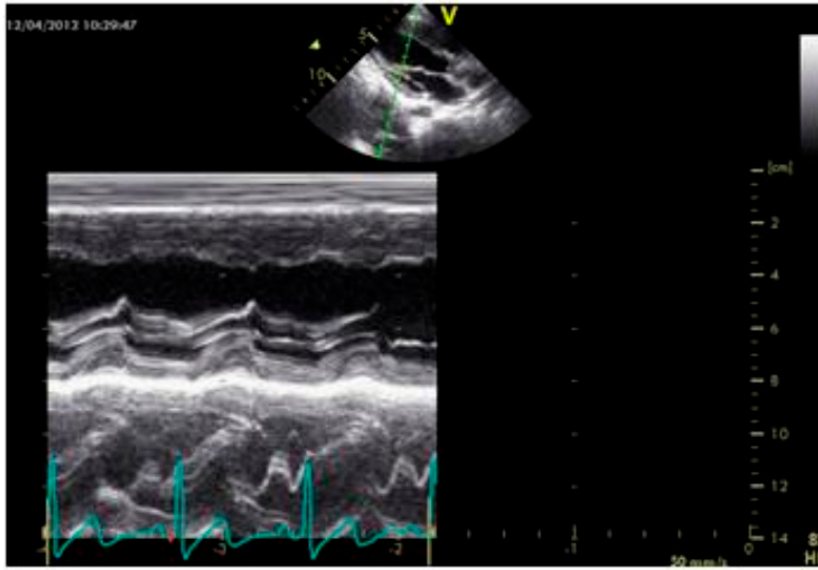
Figure 6. showed M mode echocardiogram in β thalassemia major child.